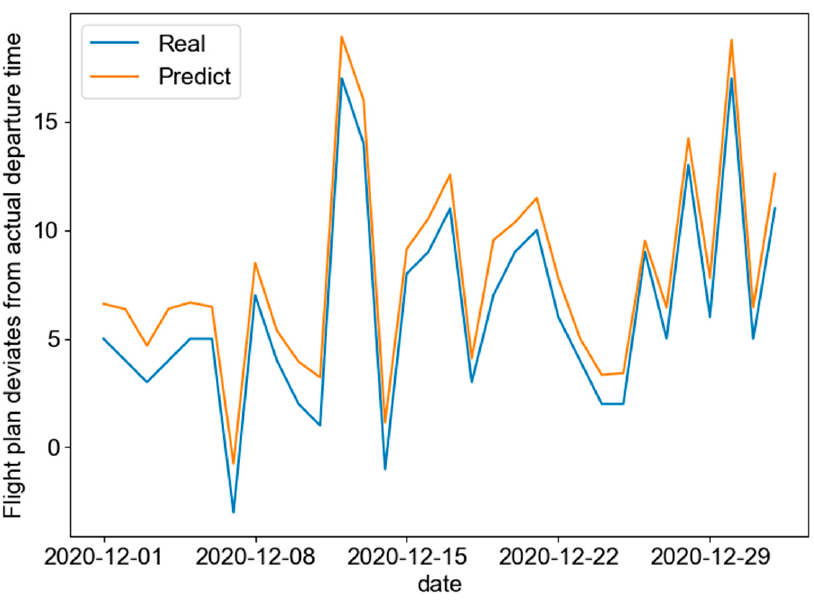
Figure 4. AQ1033 validation set fitting graph.